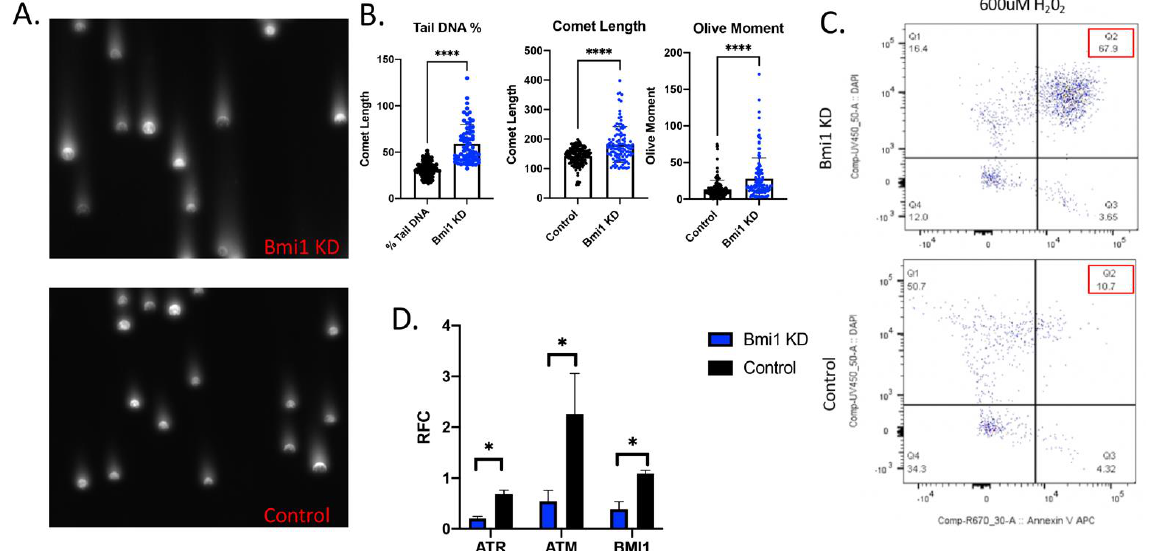
Figure 3. Bmi1 knockdown reduces survival and causes DNA damage in CBSCs: ( A ) representative images of the comet assay in the Bmi1KD CBSCs and the control CBSCs; ( B ) comet assay box plot analysis from the Bmi1 KD and the control CBSCs measuring Tail DNA Percent ( p value < 0.0001), comet length ( p value < 0.0001), and olive moment ( p value < 0.0001 ( n = 3); ( C ) flow cytometry gating strategy to determine apoptotic population. Dead cells were included in the analysis, and cells were gated on mCherry to ensure that only successfully infected cells were included in analysis. Percent of cells stained with AnnexinV positive and DAPI negative staining indicating apoptosis and necrosis ( n = 3); and ( D ) the relative fold change (RFC) of PCR analysis using RNA from the Bmi1 KD and control CBSCs to assess DNA damage genes including ATR and ATM (ATR p value 0.001, ATM p value 0.022, Bmi1 p value 0.034, n = 3). * p < 0.05, **** p <